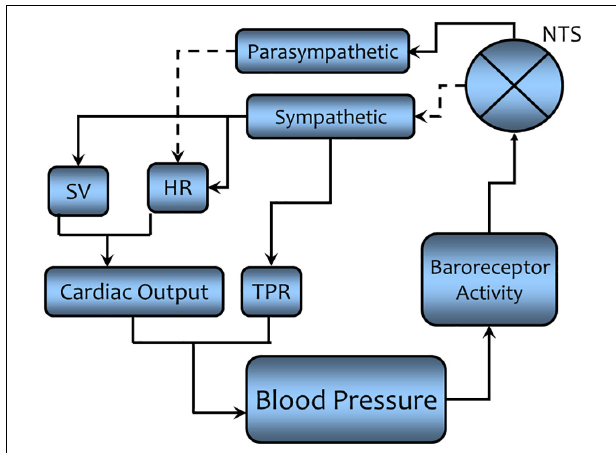
FIGURE 7 | A simplified schematic representation of the regulation of arterial blood pressure as a physiological example of negative feedback regulation. A solid line indicates that the connected components are directly related (an increase in one component leads to an increase the connected components, while a decrease will lead to a decrease in the connected components). A dashed line indicates the connected components are inversely related (an increase in one component leads to a decrease in the connected component while a decrease will lead to an increase in the connected component). Negative feedback regulation acts to maintain the arterial blood pressure within a narrow range of values (see text for a detailed description). NTS = nucleus tractus solitarius, the site where sensory information is processed and the efferent response is initiated. It acts as a “barostat” analogous to the “thermostat” in room temperature regulation. SV = stroke volume (the amount of blood ejected by the heart with each ventricular contraction), HR = heart rate, the number of beats (ventricular contractions) per minute, TPR = total peripheral resistance, the resistance to the forward movement of blood (inversely related to the blood vessel